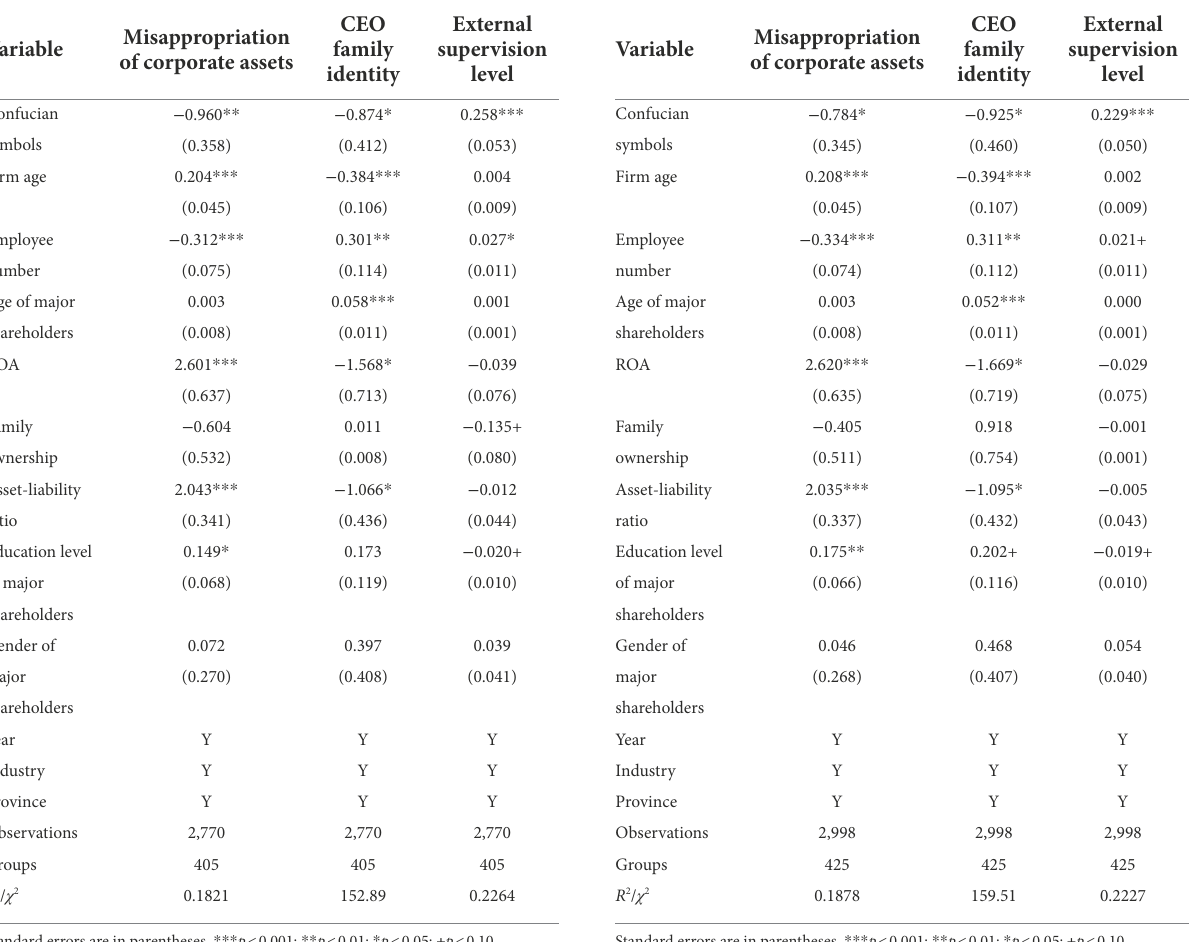
TABLE 6 Results under the criteria of “family shareholding ratio not less than 25%.”